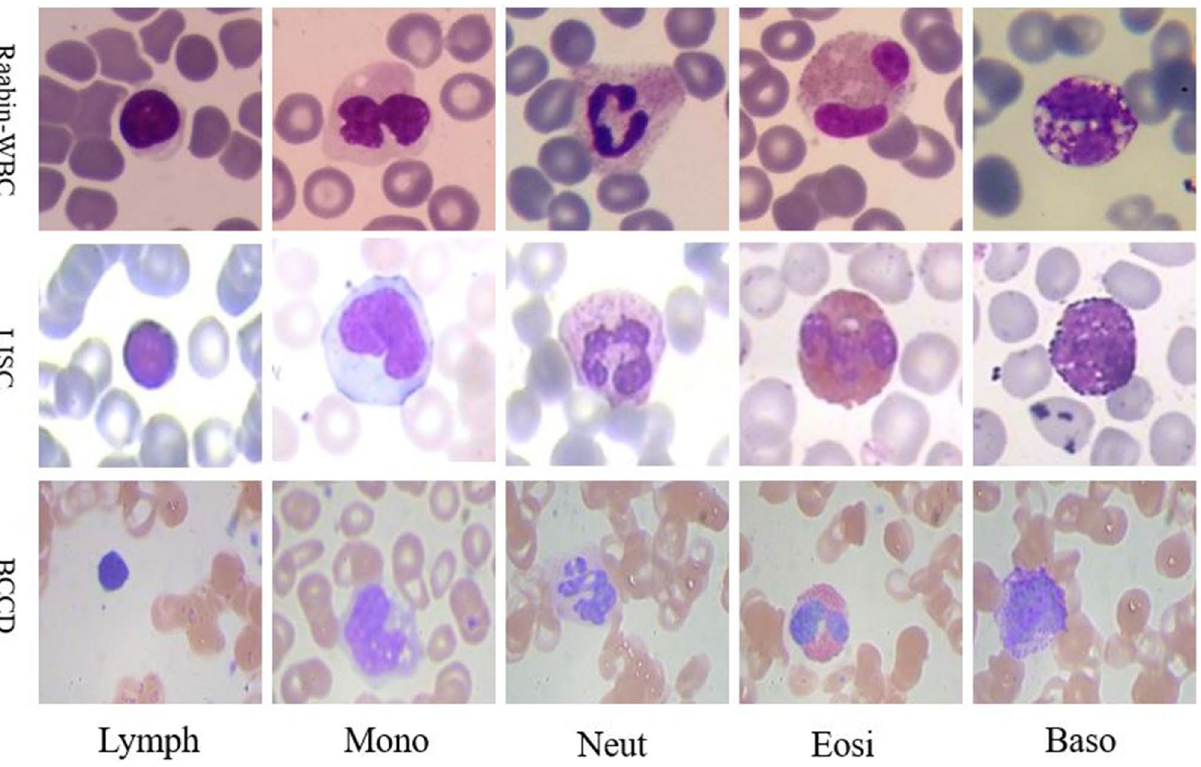
Figure 2. Some samples of the WBCs in Raabin-WBC, LISC, and BCCD datasets; Lymph (lymphocyte), Mono (monocyte), Neut (neutrophil), Eosi (eosinophil), Baso